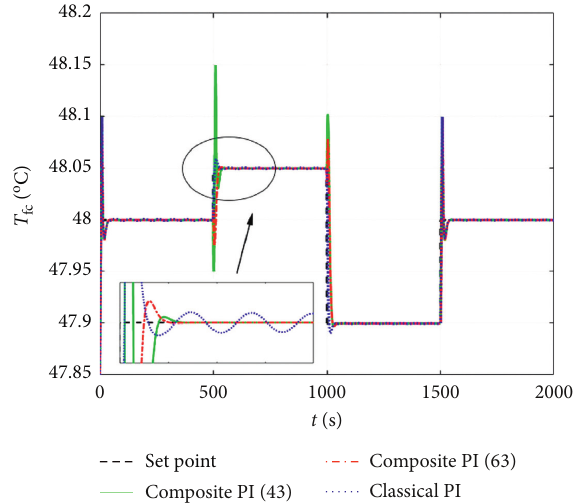
Figure 12: The small variation of temperature regulation profiles by the proposed composite PI controller ((37) and (57)) and the classical